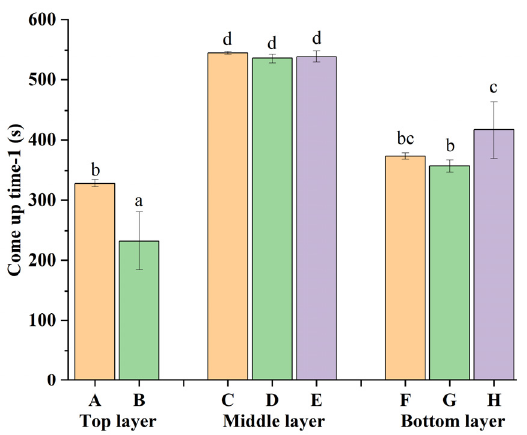
Figure 4. Come-up time-1 from 30 °C to 60 °C under 180 mm electrode gap at different points of the PSPS sample. Six points (A, B, C, D, F, and G) were in soup and two points (E and H) were in pork slices. (Different lowercase letters (a–d) indicate a significant difference ( p < 0.05)).